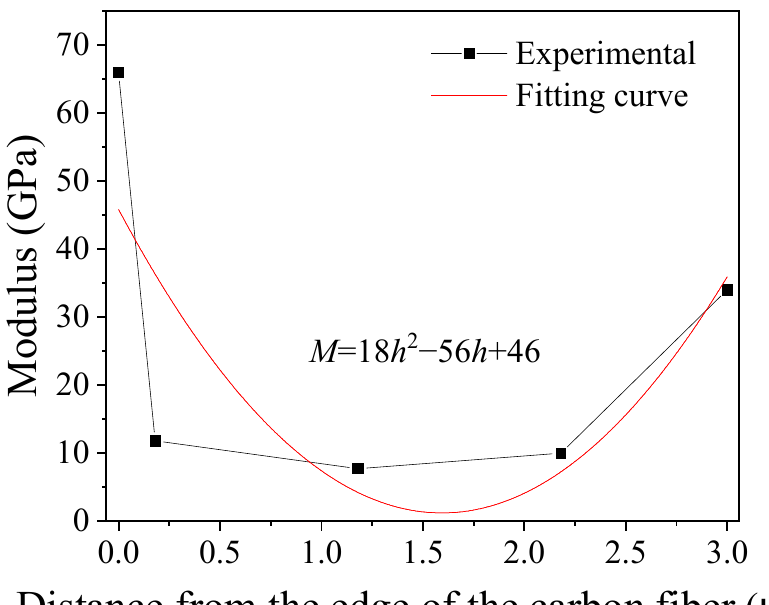
Figure 7. Experimental (symbols) and fitted (curve) modulus along the EF segment in Figure 6. The modulus along the CD segment is shown in Figure 8. It can be seen from the figure that as the distance between the two fibers increases, the modulus gradually decreases, and when the distance between the two fibers is greater than 4.5 µ m, their mutual influence can be ignored. The widths of the interface regions around the carbon and glass fibers are 1.5 and 2 µ m, and the distance over which there exists a mutual influence is slightly larger than the sum of their respective interface widths. The modulus in the region between the carbon and glass fibers satisfies the following parabolic trend: M = 8.6 h 2 − 49 h + 68. The modulus at the middle of this distance is the same as that of the matrix, indicating that when the distance is greater than 4.5 µ m, the mechanical properties of the matrix are not affected by the fibers on either sides.